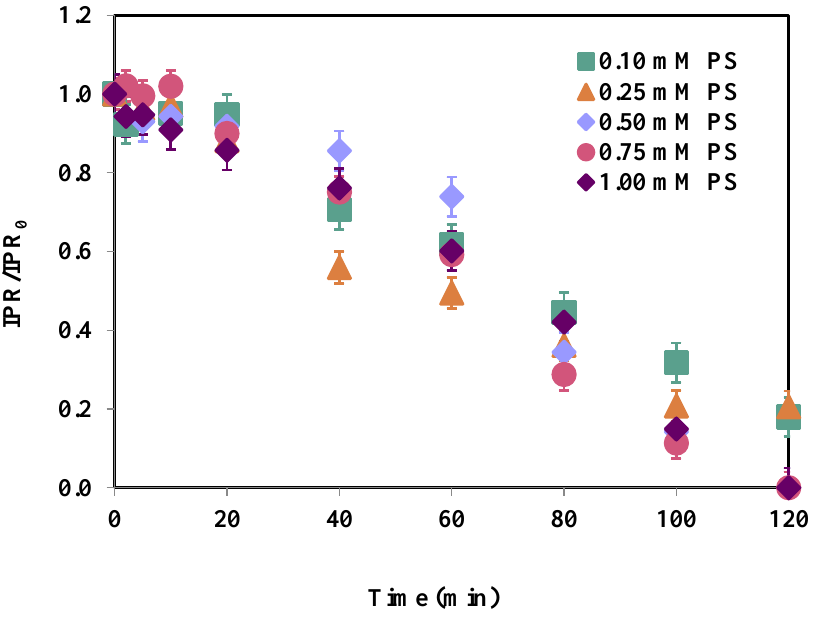
Figure 4. Changes in normalized IPR concentration during ZVA/PS treatments in DW at varying initial PS concentrations. IPR = 2 mg/L; ZVA = 1 g/L; pH = 3.0. In another related study, the effect of PS concentration (0.20 – 4.00 mM) on 26.28 mg/L trichloroethylene removal through ZVA/PS was explored [55]. In that study, experimental findings revealed that the rate constants calculated for trichloroethylene were enhanced progressively from 0.0034 min −1 to 0.0395 min −1 by increasing the PS concentrations from 0.20 mM to 2.00 mM. However, the rate constants of trichloroethylene removal decreased upon further increase of the initial PS concentration due to scavenging of SO 4 ●− by the excessive concentration of PS that might consume the abundant SO 4 ●− generated through the following equations [55] and inhibit trichloroethylene removal: